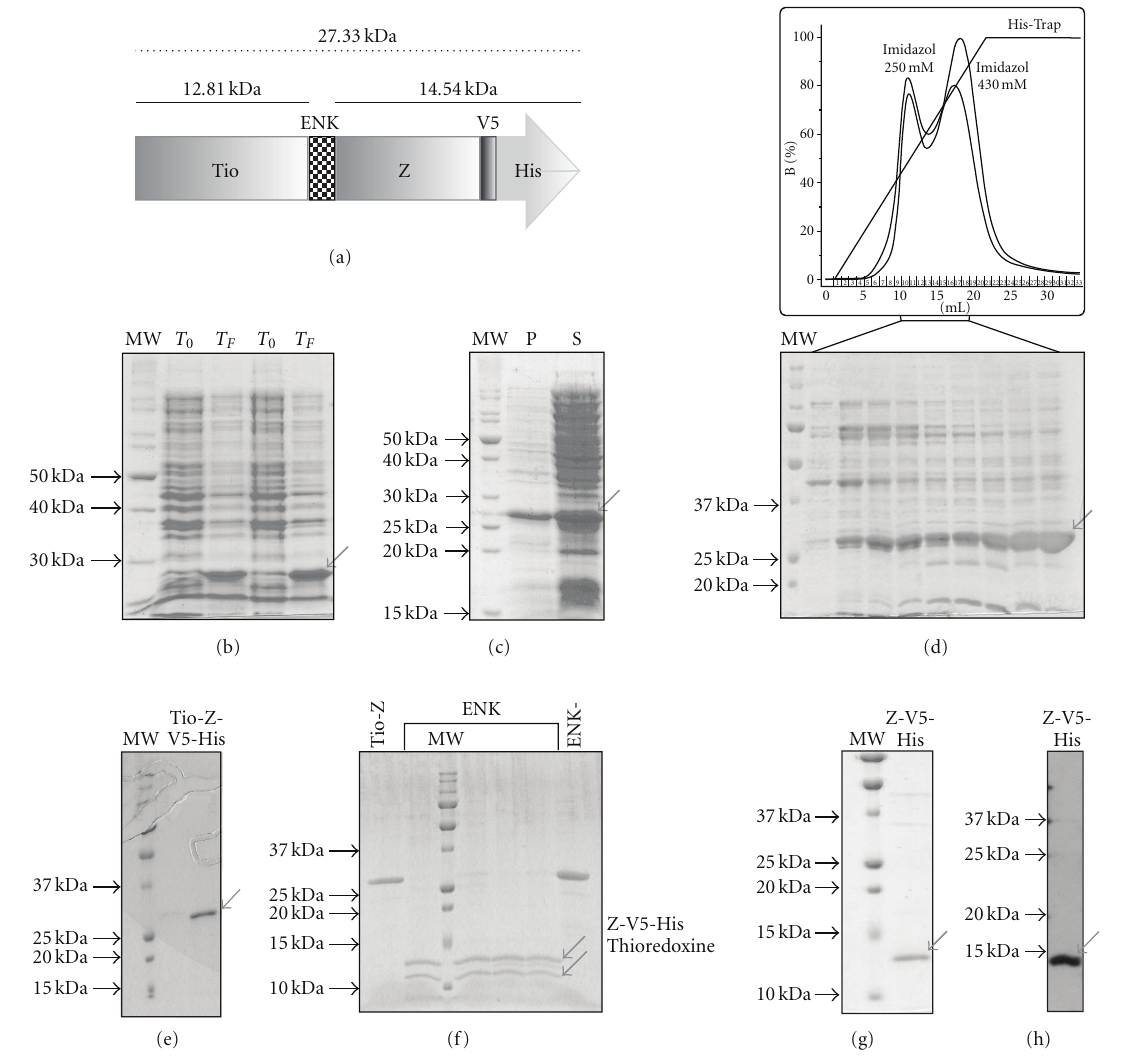
Figure 2: Expression, purification and cleavage of Tio-Z-V5-His . (a) Diagram for the recombinant Tio-Z-V5-His protein expressed in E. coli . The dark gray region represents the thioredoxine (Tio) fusion protein; the striped block indicates the specific protease Enterokinase (Gly-Gly-Gly-Gly-Lys ↓ ) target sequence; the light gray region corresponds to Z protein; the black line shows the V5 epitope localization; and the white arrow indicates the His-tag. The molecular weight of the complete recombinant protein is 27.3 kDa, the cleavage products being 12.8 kDa (thioredoxine) and 14.5 kDa (Z-V5-His). (b) 12% SDS-PAGE of samples of the whole cell culture at initial time ( T 0 ) and after 4h at 37 ◦ C ( T F ). The arrow indicates Tio-Z-V5-His recombinant protein. (c) 15% SDS-PAGE of the centrifuged cell lysate of E. coli expressing Tio-Z-V5-His. S : supernatant from the whole cell lysate expressing Tio-Z-V5-His (soluble fraction). P : pellet from the whole cell lysate (insoluble fraction). The arrow indicates Tio-Z-V5-His. (d) The chromatography profile (upper part) corresponds to the elution of the bound protein with an imidazole gradient (black line). Fractions 10 to 18 (indicated with a bracket) were loaded on 12% SDS-PAGE. The arrow indicates Tio-Z-V5-His. In the lower part, is shown the 12% SDS-PAGE from Immobilized Ni 2+ a ffi nity chromatography (IMAC) His-trap (Amersham) fractions of the soluble fraction of Tio-Z-V5-His ( S , from (c) part). (e) 12% SDS-PAGE of the gel filtration (Superdex 200) fractions 13 to 21 (pooled), of the Tio-Z-V5-His purification. This sample was the substrate of the cleavage with the enterokinase. (f) 15% SDS-PAGE of the cleavage of Tio-Z-V5-His with the protease enterokinase. The first lane is the purified Tio-Z-V5-His. The following lanes correspond to an incubation of 2:30 h at 37 ◦ C with di ff erent dilutions of the enterokinase (indicated with a bracket). The last lane is Tio-Z-V5-His protein without treatment. The arrows indicate the two peptides produced by the cleavage, shown in diagram A. (g) 15% SDS-PAGE of the purification of Z-V5-His with IMAC. (h) Western blot of the cleavage products of Tio-Z-V5-His with Enterokinase. The arrow indicates